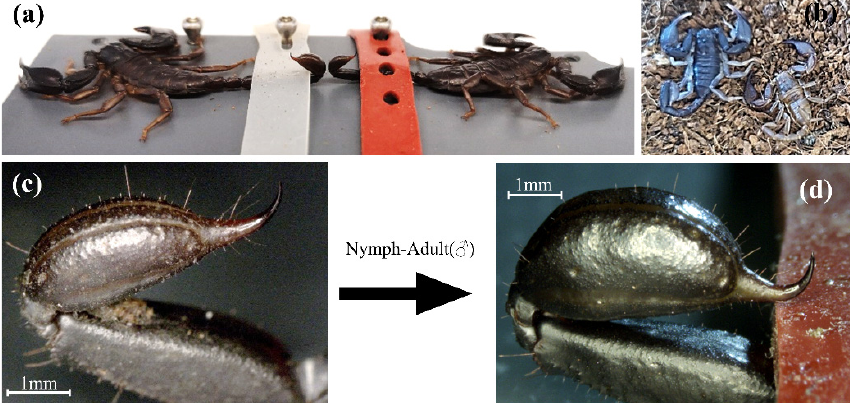
Figure 1. External telson morphology of E . italicus . ( a ) Comparison of male (left) and female (right) specimens with differently shaped telsi. ( b ) Male after adult molt with last instar exuvia. ( c , d ) Telson morphology of a single individual before ( c ) and after ( d ) molting into a male.